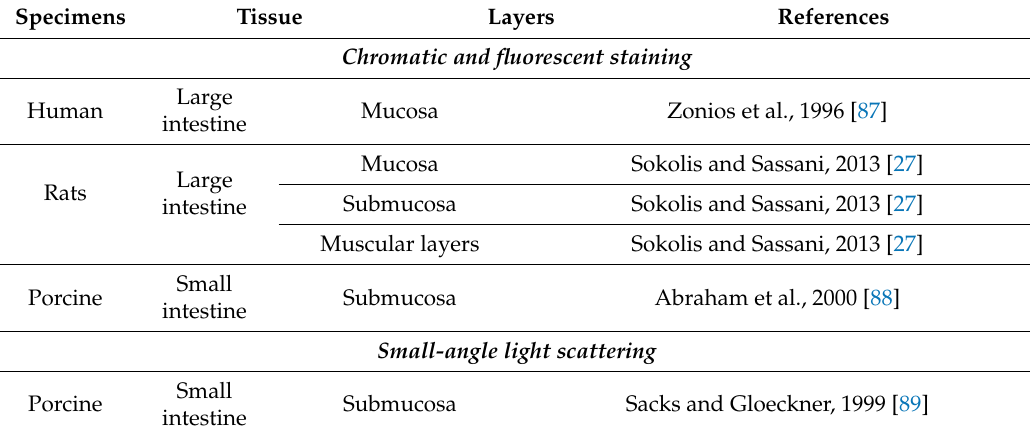
Table 2. Quantification of collagen fibers in the small and large